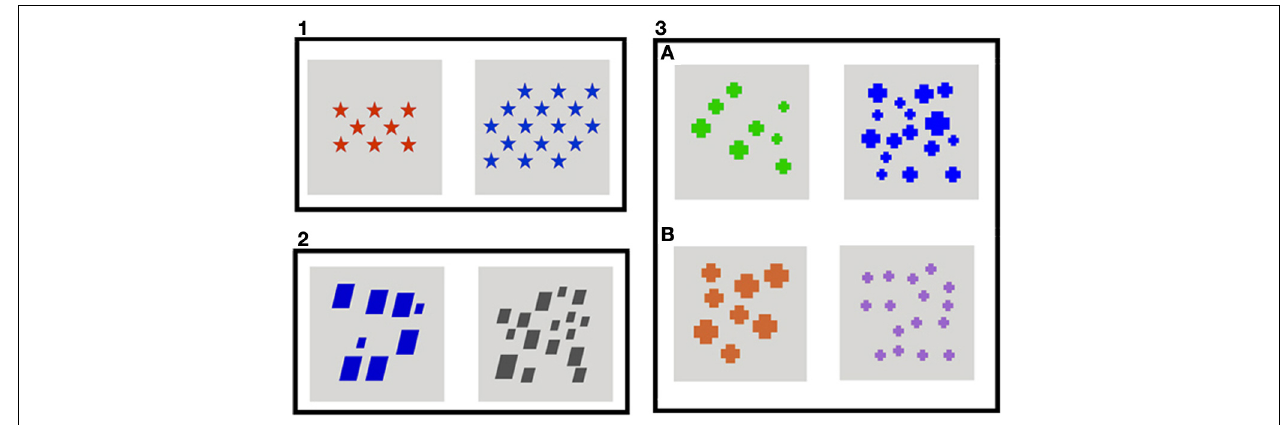
FIGURE 1 | Example: Comparison 8 vs. 16 across all different visual controls. (1) Density, (2) Total Filled Area, (3A) Correlated Area, and (3B) Anti-correlated Area trials.